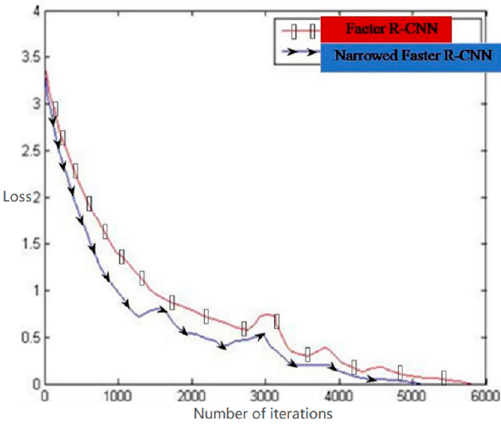
Figure 12. Training loss function line chart.